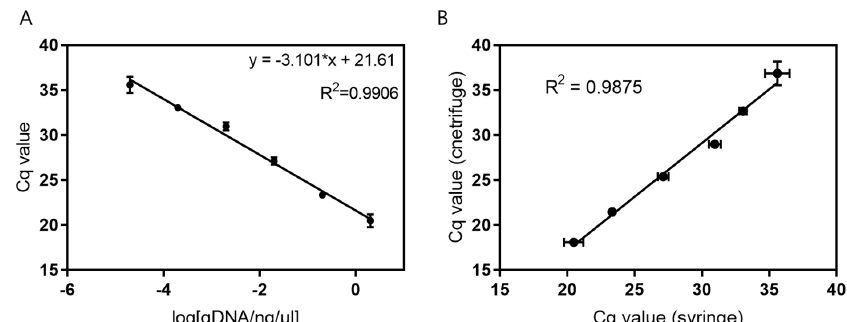
Figure 3. Detection sensitivity of Escherichia coli gDNA. ( A ) Linear correlation of the logarithmic value of Escherichia coli gDNA concentration with Cq values. ( B ) Comparison of Cq values obtained using the syringe-based ( x -axis) and centrif- ugation-based ( y -axis) extraction procedures. Data are expressed as mean ± standard deviation; n = 3 technical replicates. gDNA, genomic DNA; Cq, cycle quantification value.